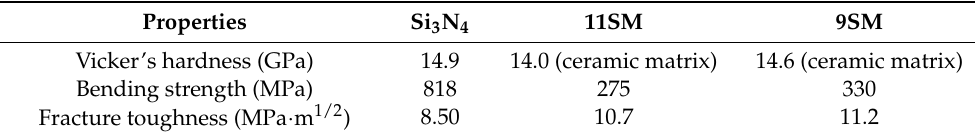
Table 5. Mechanical properties of composite